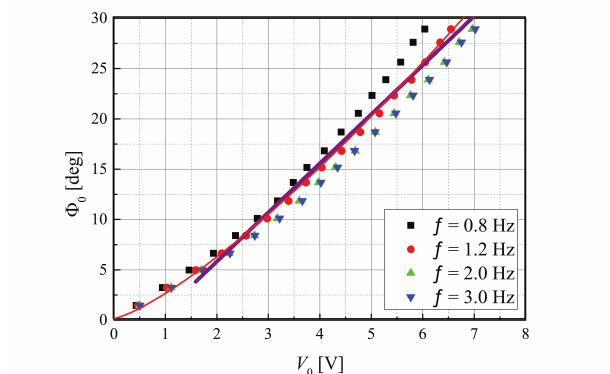
Figure 5. Peak-to-peak bending angle according to the peak-to-peak voltage of the sensor. The black squares, red circles, green upward-pointing triangles, and blue downward-pointing triangles represent the voltage outputs of the sensor at the operating frequencies of 0.8, 1.2, 2, and 3 Hz, respectively. The red and purple solid lines represent the power-fitted bending angle and linear fitted bending angle within the bending angle range from 5° to 29° according to the output voltage at f = 1.2 Hz, respectively.